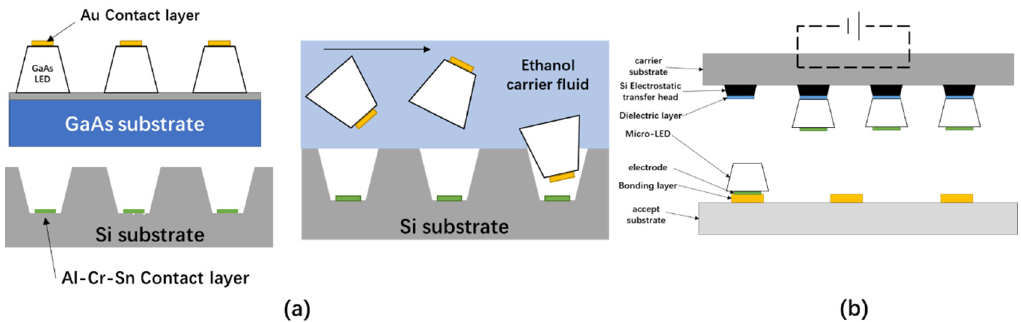
Figure 5. ( a ) The loading process of fluid self-assembly technology. Reproduced from [45], with permission from Institute of Electrical and Electronics Engineers, 1994; ( b ) Principle diagram of electrostatic transfer technology [47].